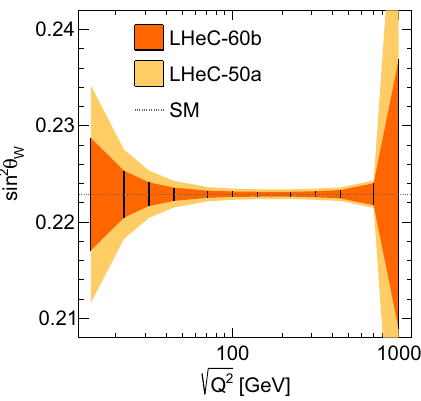
Fig. 7 Expected uncertainties of the weak mixing angle determined in sub-regions of Q 2 . Two scenarios for the simulation of LHeC inclusive NC/CC DIS data are displayed, LHeC-50a and LHeC-60b. The SM expectation is displayed as a dotted